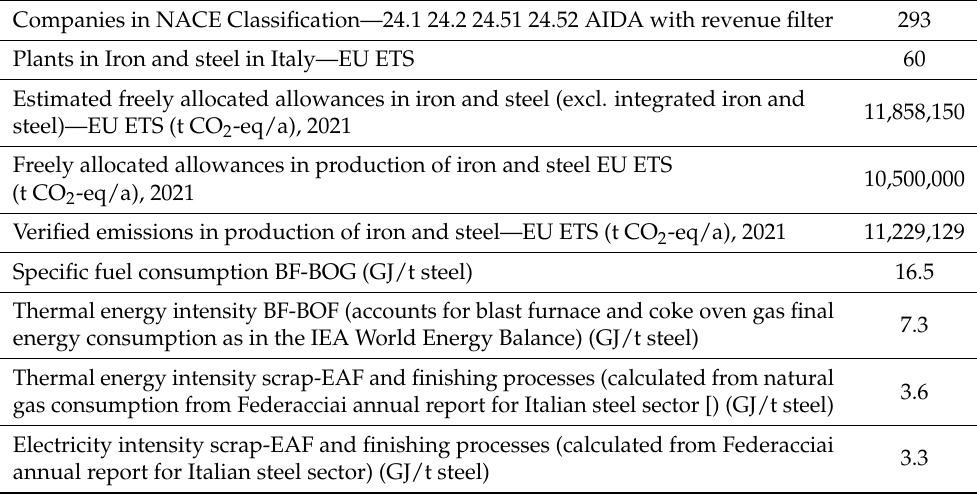
Table 9. Summary data for iron and steel production plants in Italy under EU